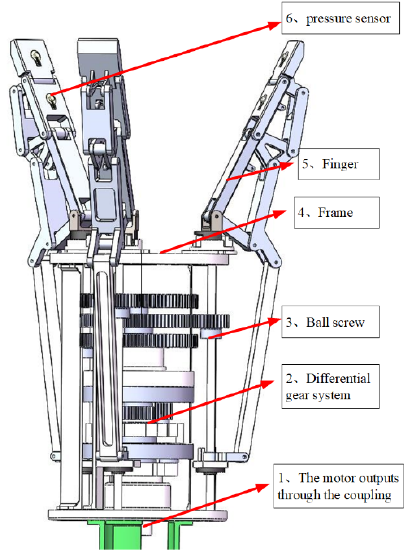
Figure 2. General assembly drawing of the manipulator.